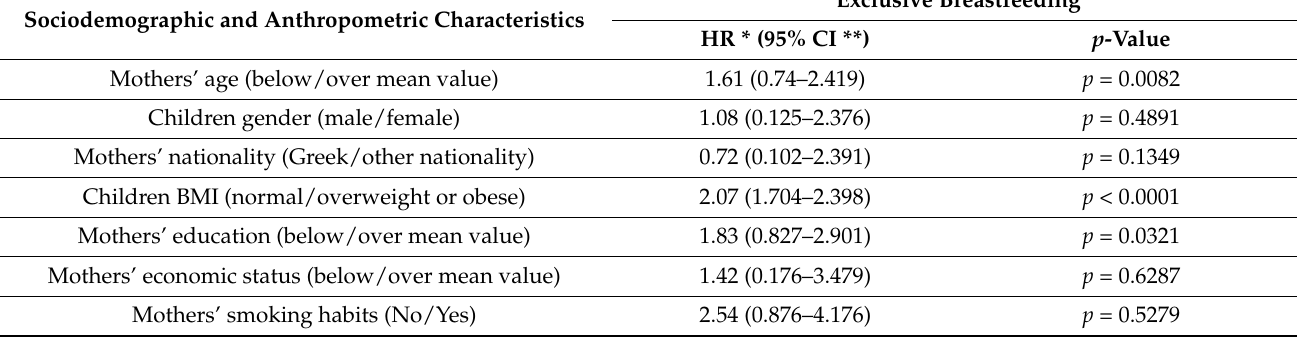
Table 3. Multivariate logistic regression analysis for assessing the influence of exclusive breastfeeding on childhood overweight and obesity after adjustment for potential